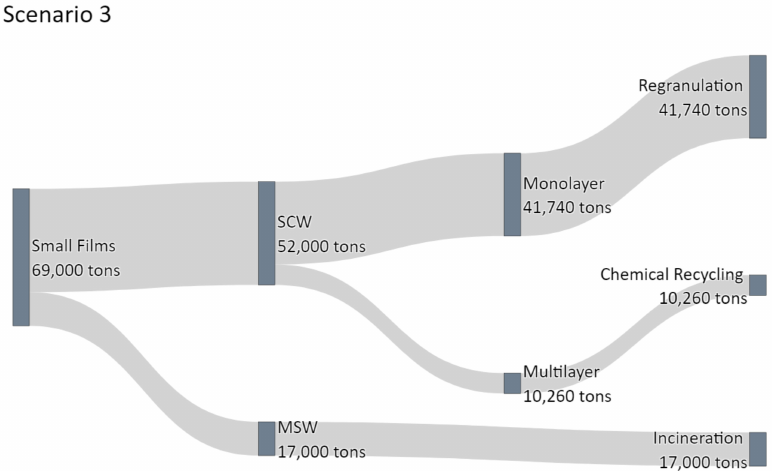
Figure 10. Sankey diagram depicting the waste flow in Scenario 3 with increased mechanical recycling of monolayer films and simultaneous increase in the chemical recycling of multilayer